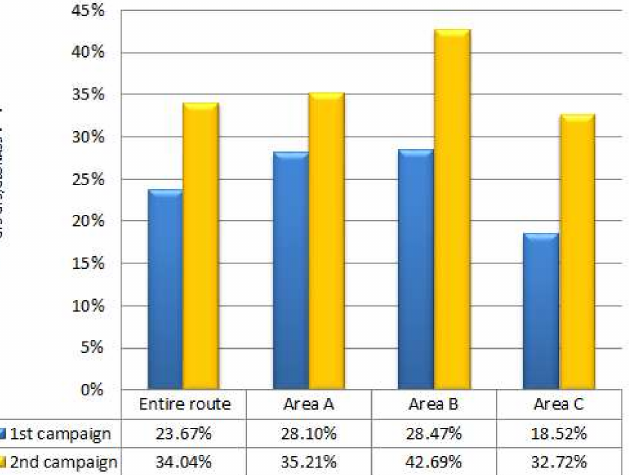
Figure 15. The relative percentage change in the average PDOP values between the continuous variant for the GPS and GPS/GLONASS